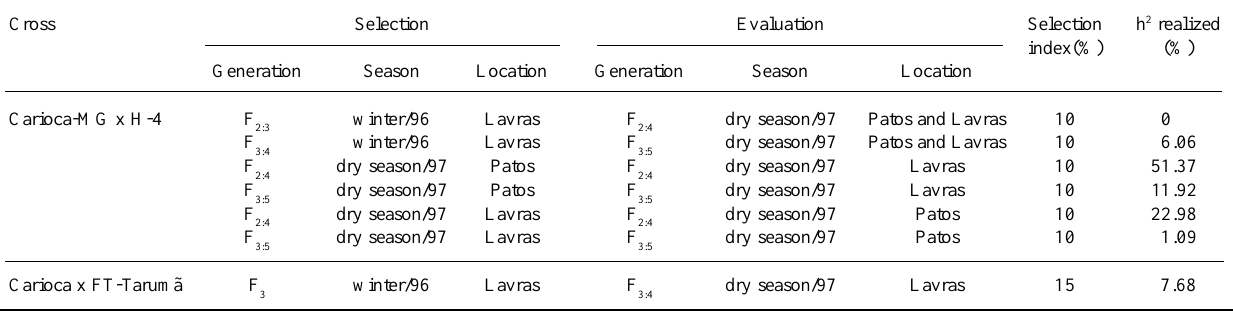
Table V - Estimates of realized heritabilities between bean families for the plant architecture value. Cross Selection